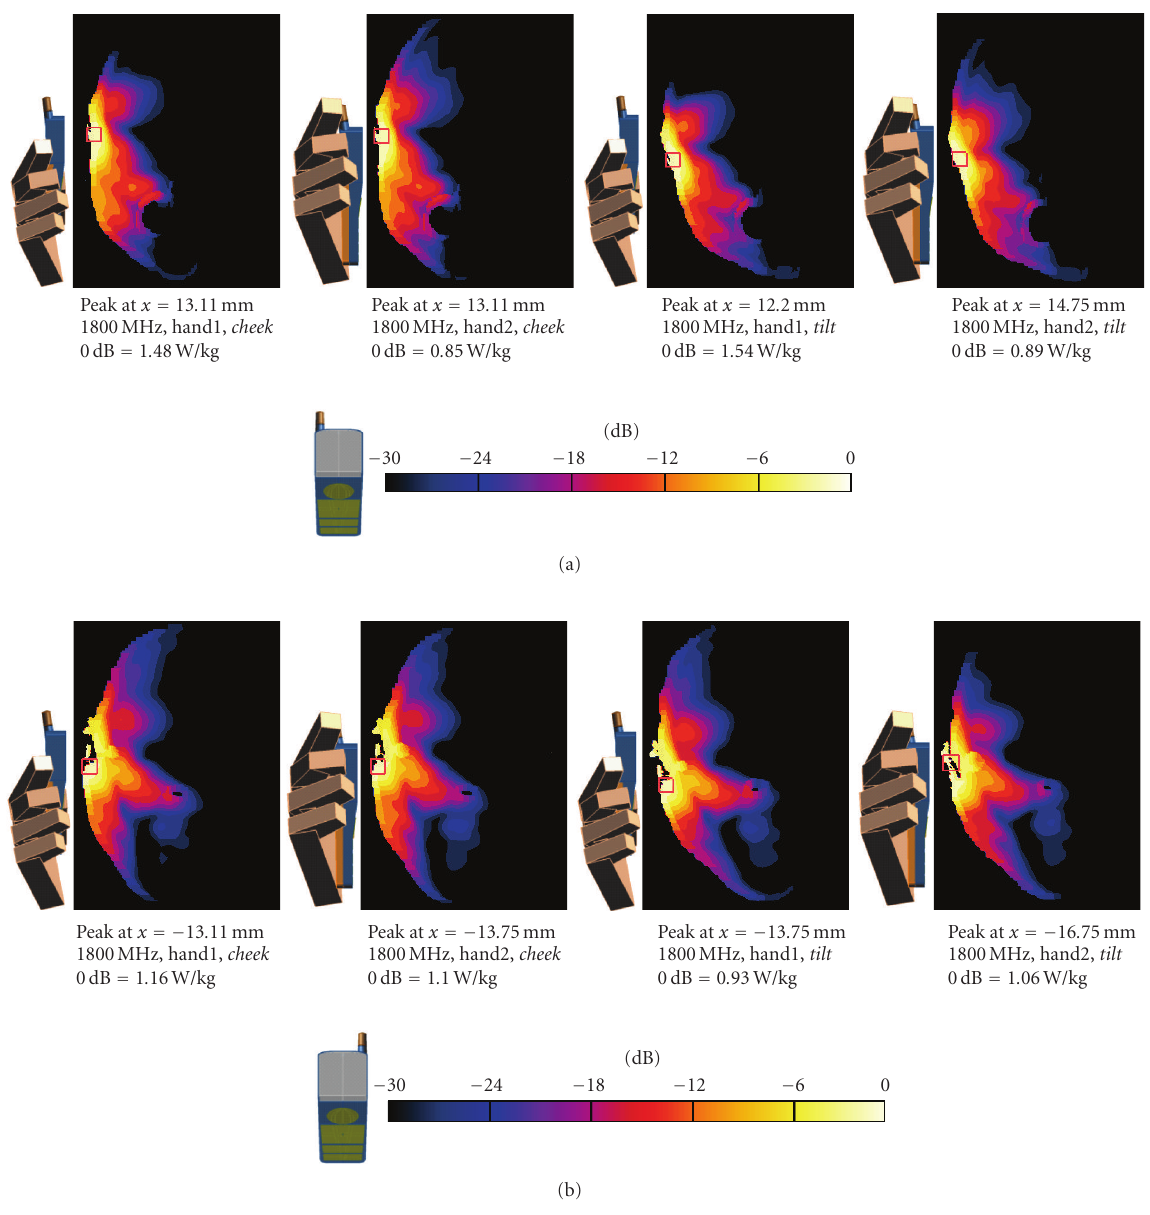
Figure 8: Sliced distribution of the averaged-peak SAR 1g in the yz -plane, normalized to 0.125 W input power, of the HR-EFH at di ff erent positions due to the exposure at 1800 MHz of (a) handset model-A1 and (b) handset